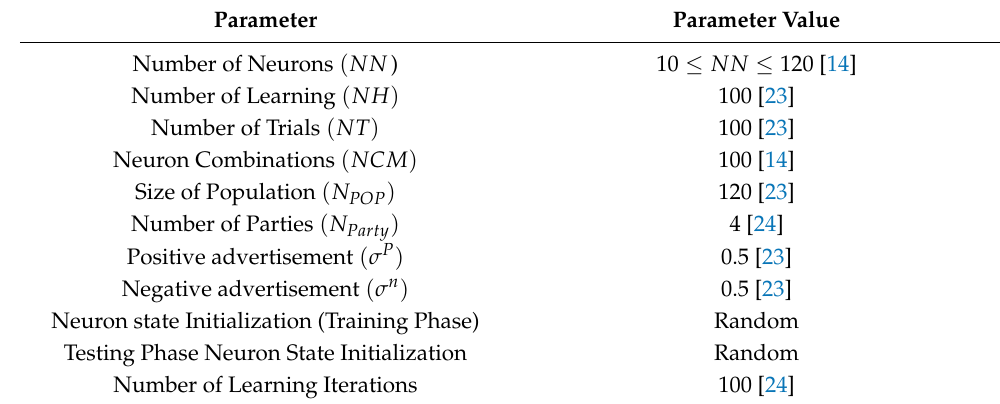
Table 3. List of parameters used in DHNNRAN k SAT-EA, DHNNRAN k SAT-GA and DHN- NRAN k